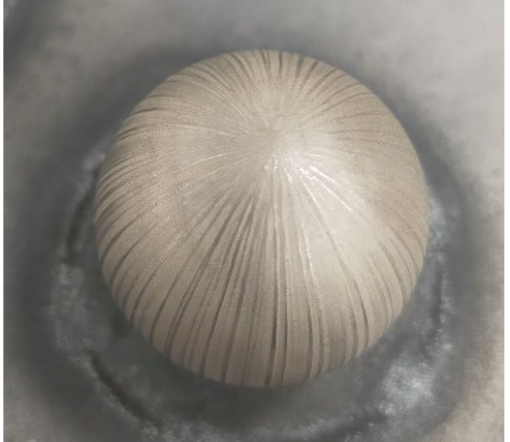
Figure 14. Ø25 mm sphere with surface markings.